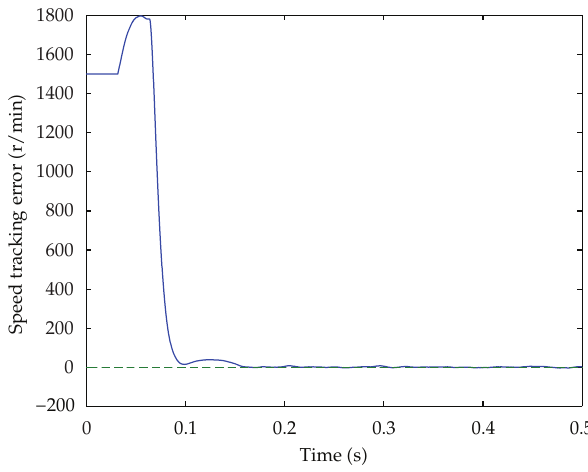
Figure 5: The speed tracking